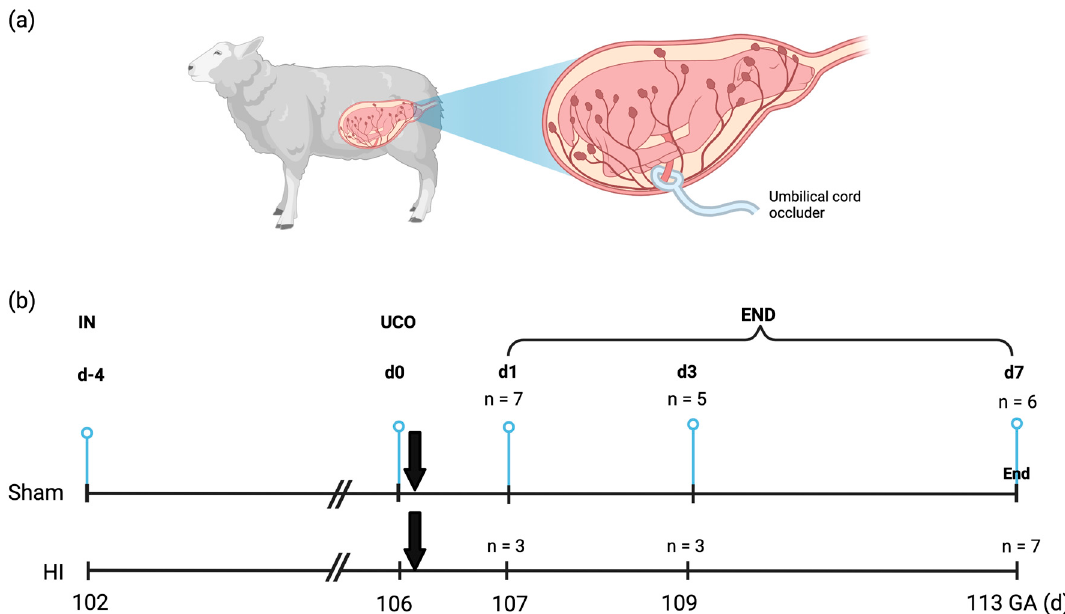
Figure 5. ( a ) Fetal sheep model with placental cotyledons (red dots) and umbilical cord (occluder) depicted; ( b ) Experimental design. Fetuses were instrumented at GA 102 (d-4) followed by 25 min of umbilical cord occlusion (UCO) or sham occlusion (d0) after four days of recovery. On d1, d3 and d7 fetuses were sacri fi ced and brain tissue was collected. Abbreviations: END—end of experiment;